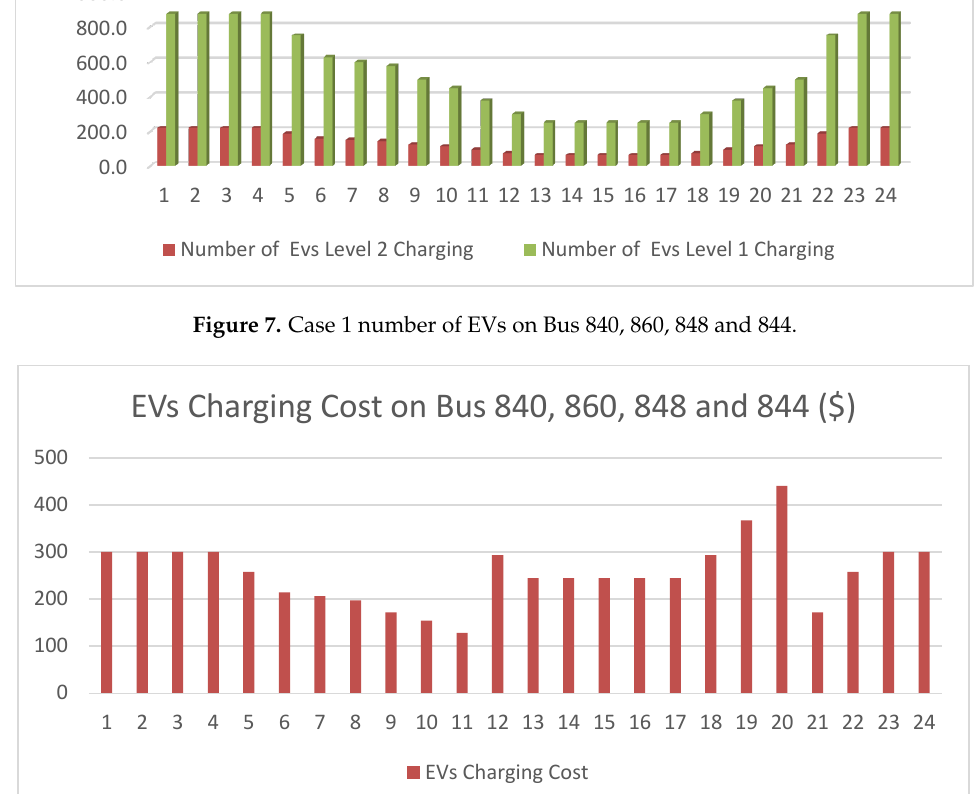
Figure 8 . Case 1 Charging Cost on buses 840, 860, 848, and 844.